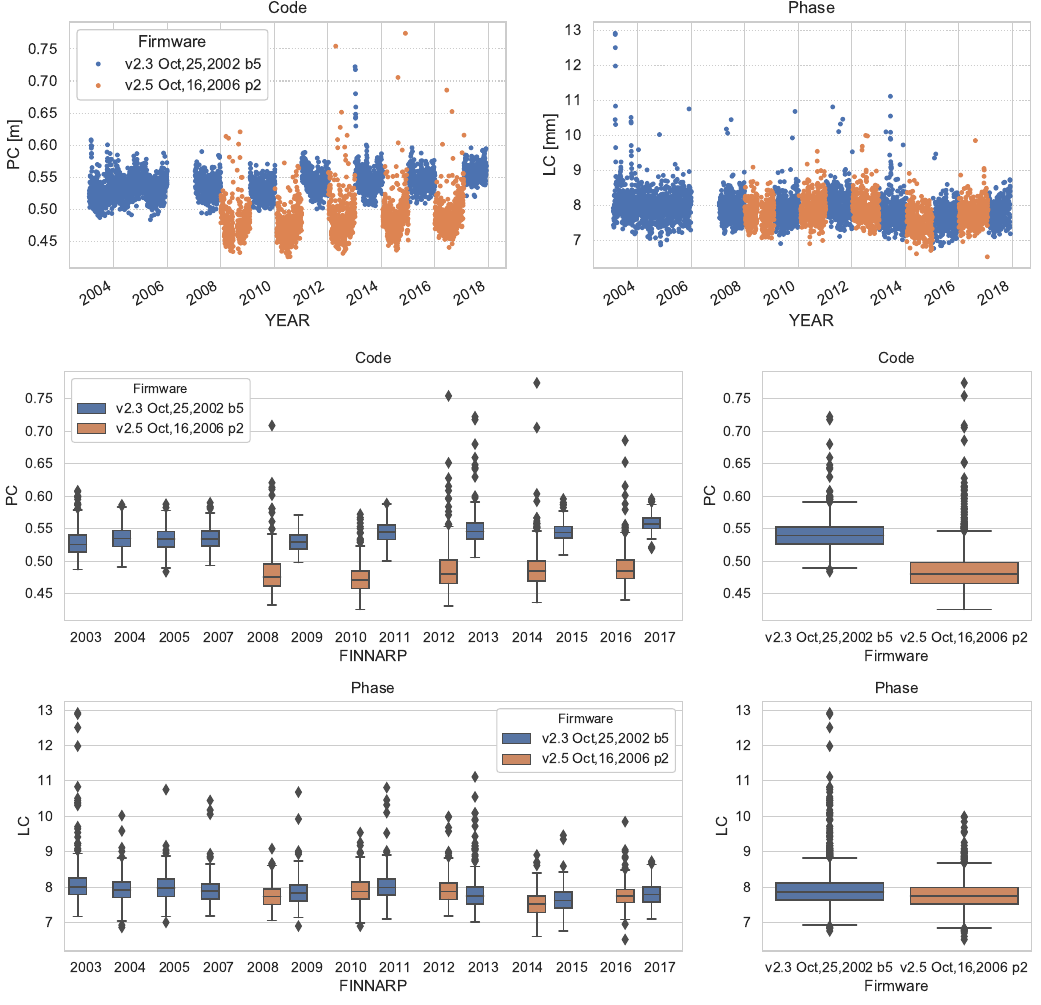
Figure 10. Daily postfit code and phase observation residuals at Aboa for the 15-year long time